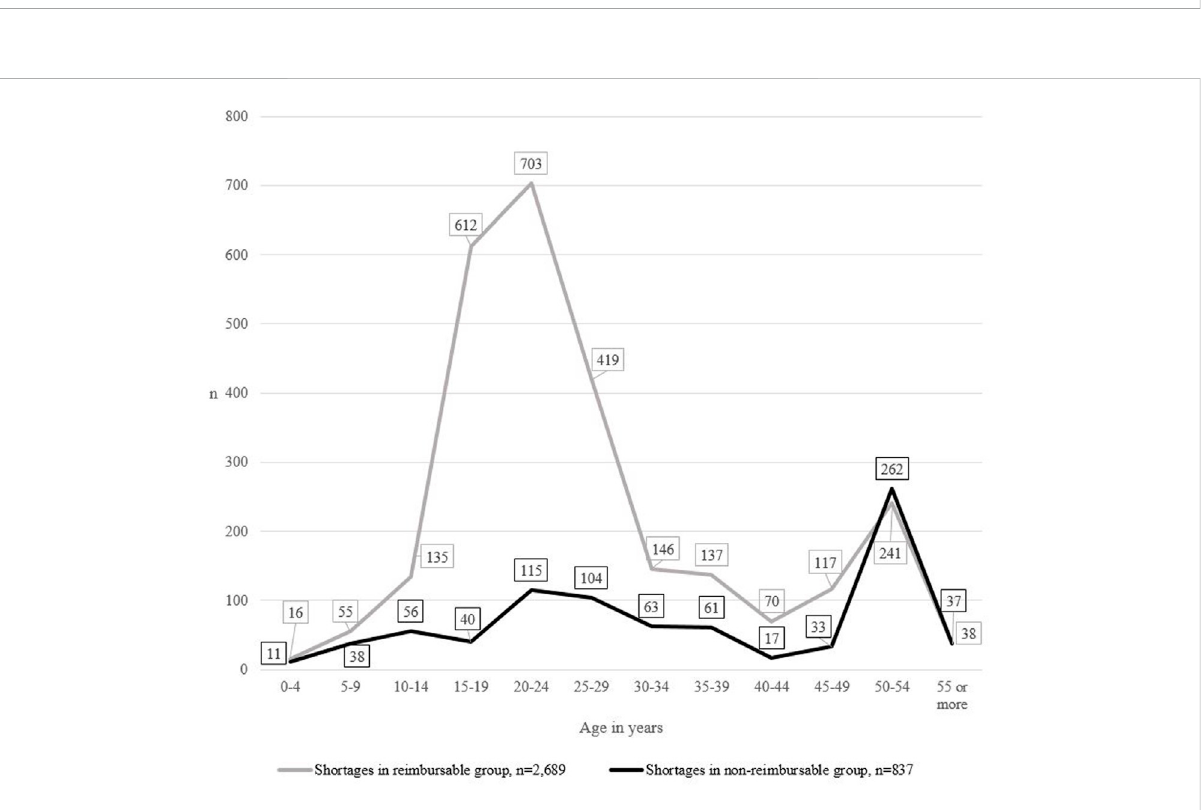
FIGURE 4 ThenumberofmedicineshortagesinFinlandfrom2017to2019( N =3,526),theageofmedicinesinshortsupplyandthereimbursementstatus of the